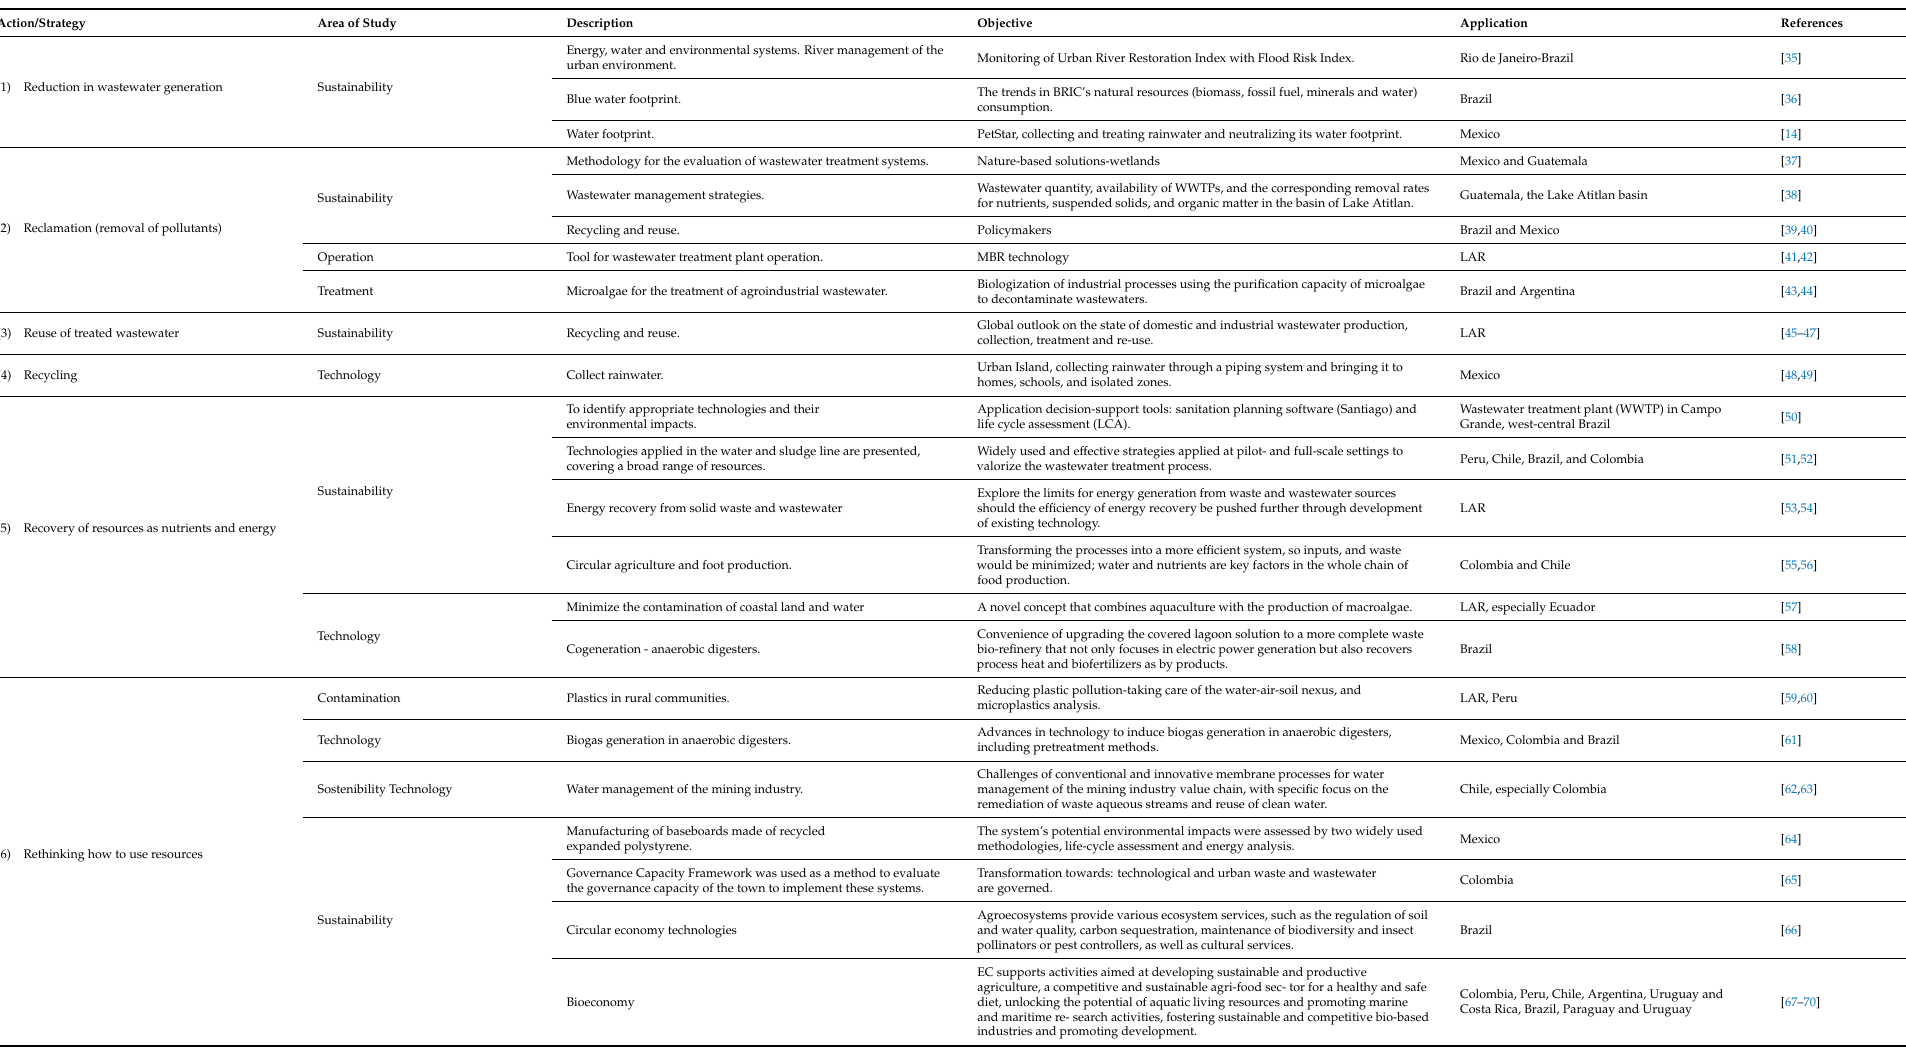
Table 1. CE integrated into the LAR in the “water” and “wastewater” sector by the